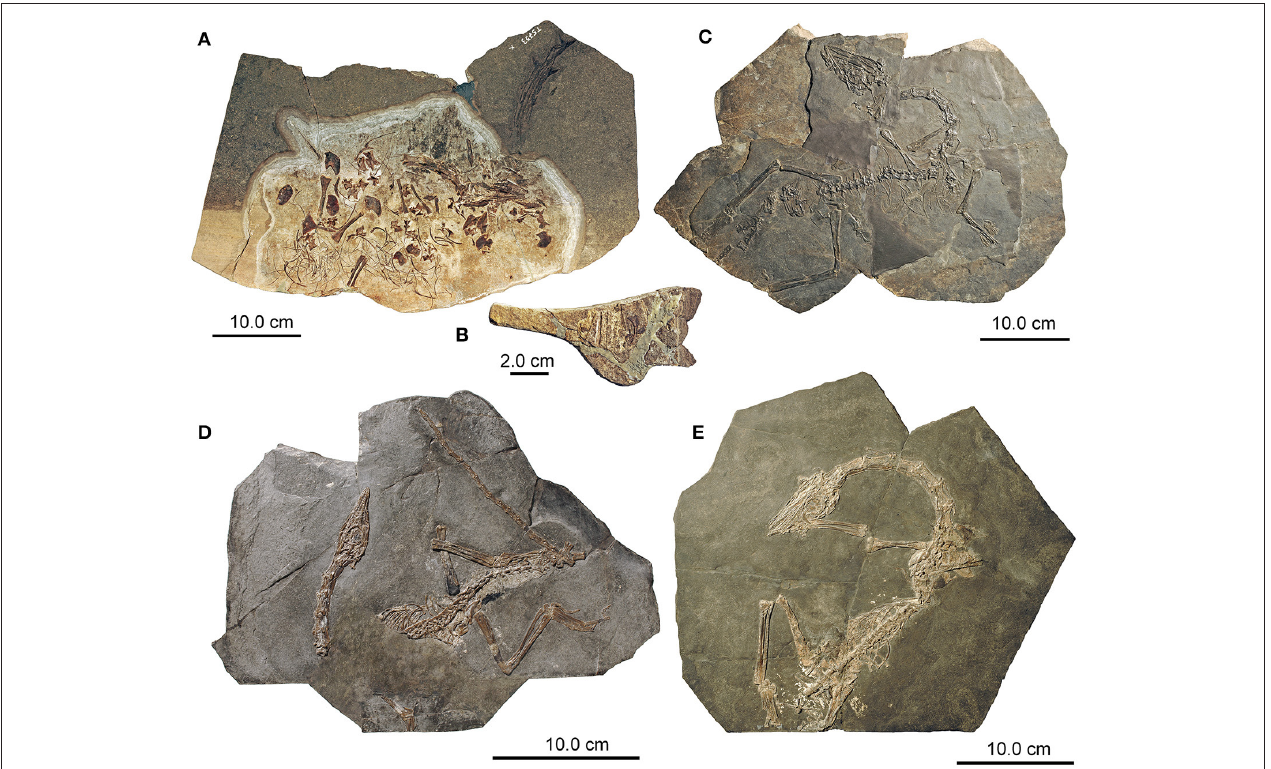
FIGURE 1 | Overview of selected specimens of Macrocnemus from Monte San Giorgio in the PIMUZ collections. (A) Main slab of PIMUZ T 1559; (B) counter-slab accompanying the main slab of PIMUZ T 1559; (C) PIMUZ T 2472; (D) PIMUZ T 4822; (E) PIMUZ T